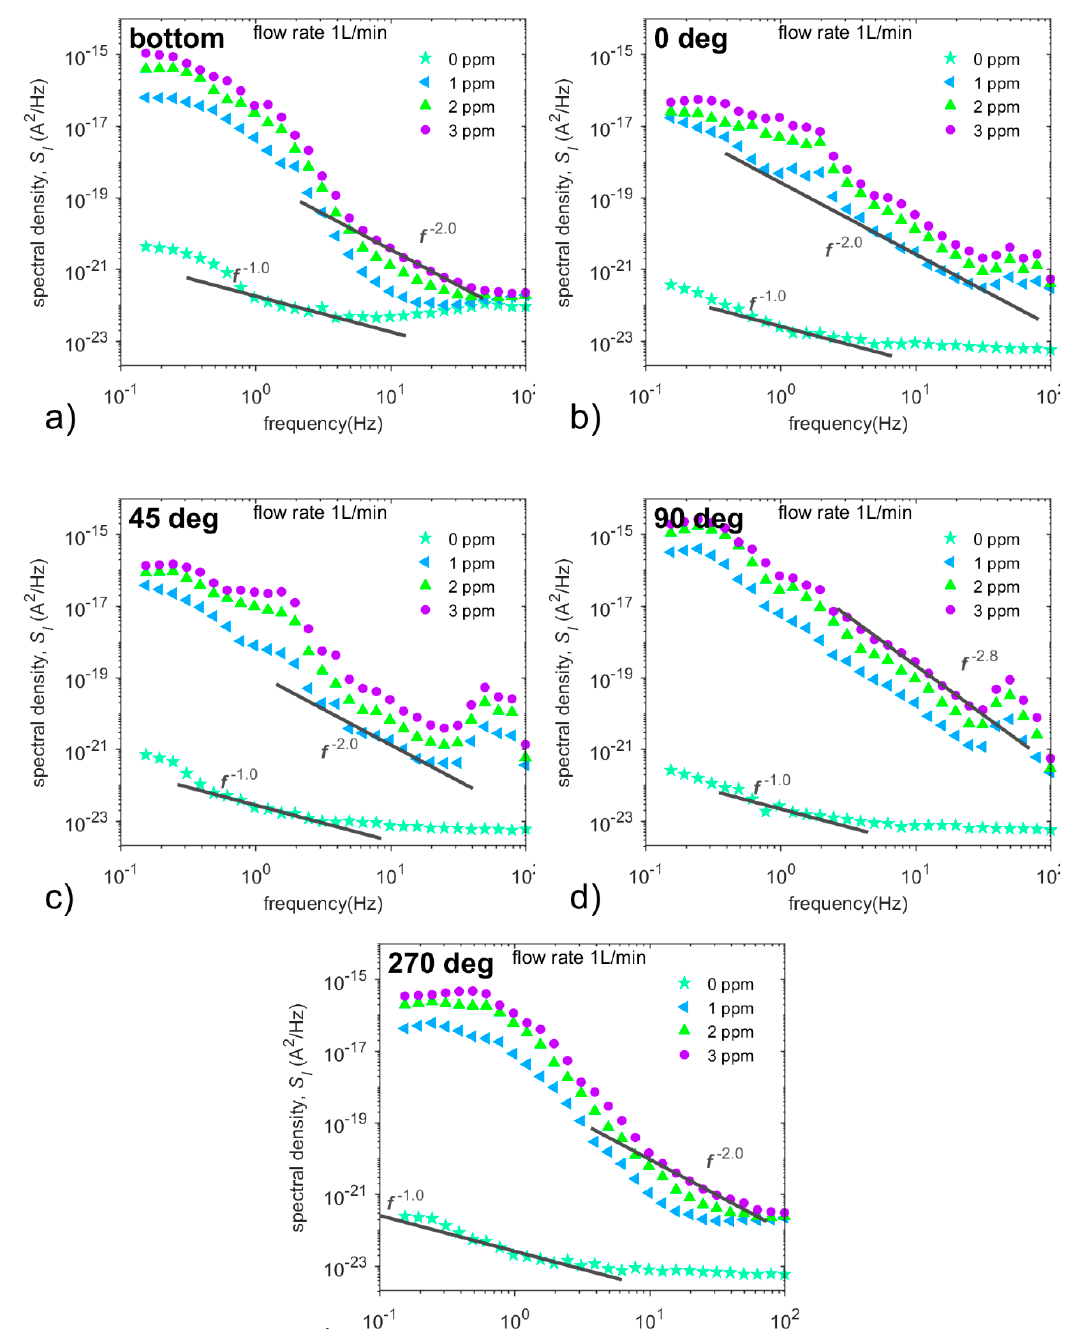
Figure 14. Spectral densities of current fluctuations depending on NO 2 concentrations at the flow rate of 1 L/min for the frequency range from 0.1 Hz up to 100 Hz for the sensor located: ( a ) at the bottom of the gas chamber, and for the sensor located in the middle of the gas chamber at the angles of ( b ) 0°, ( c ) 45°, ( d ) 90° and ( e ) 270°. Conditions: 298 K, 40%RH.